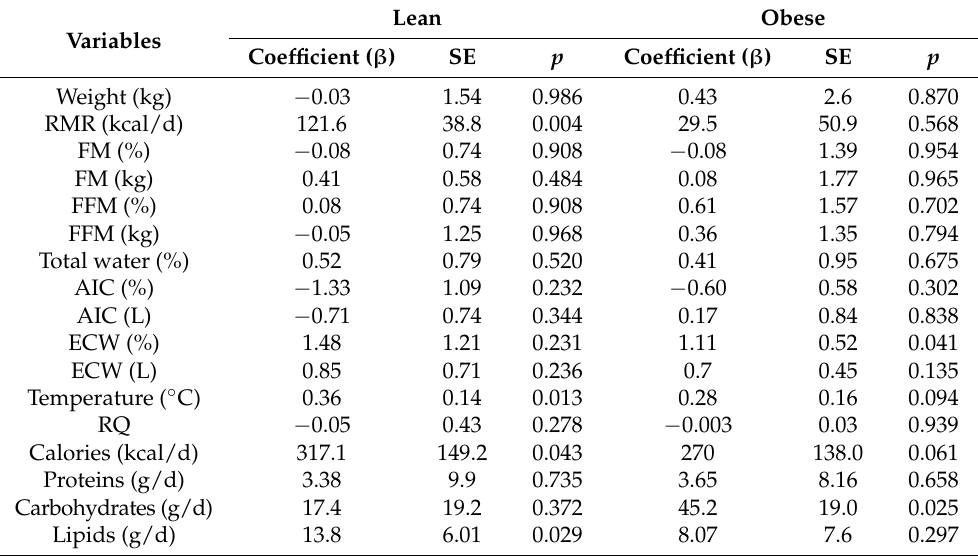
Table 2. Beta coefficient ( β ) estimated from the fit of an ANOVA model using a general linear model for each variable in the luteal phase compared with the follicular phase in lean and obese women. Lean Obese Variables Coefficient ( β ) SE p Coefficient ( β ) SE p Weight (kg) −